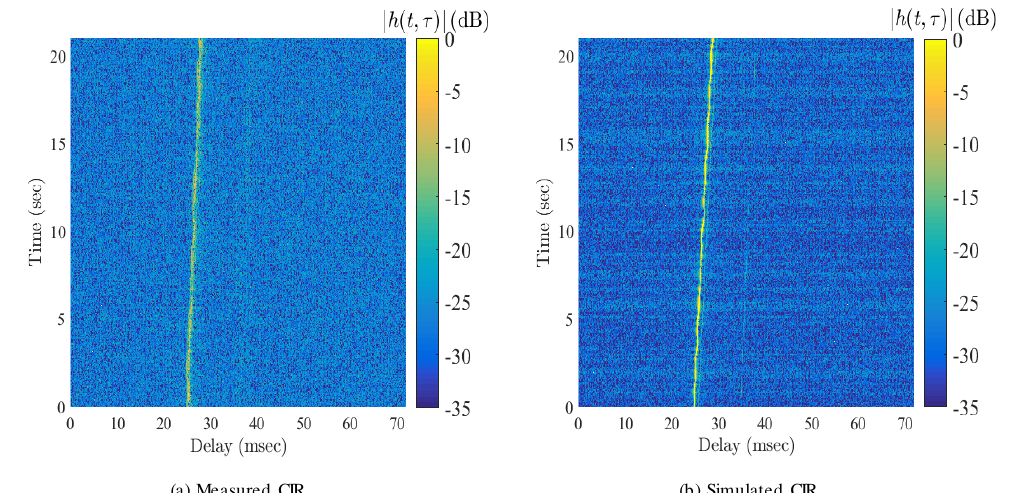
Figure 8. Measured and simulated channel impulse responses.